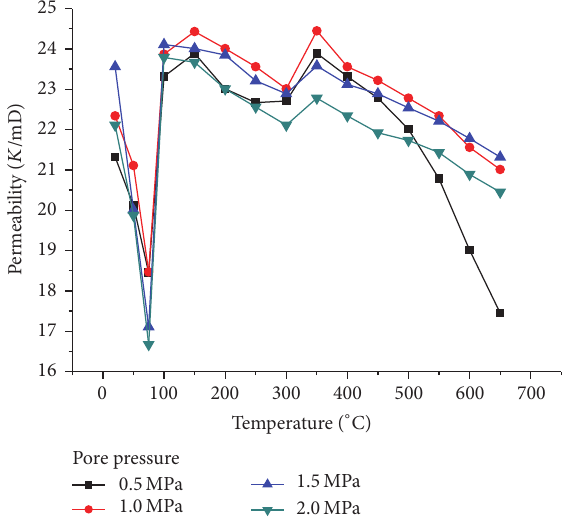
Figure 11: Variations of permeability with temperature (category